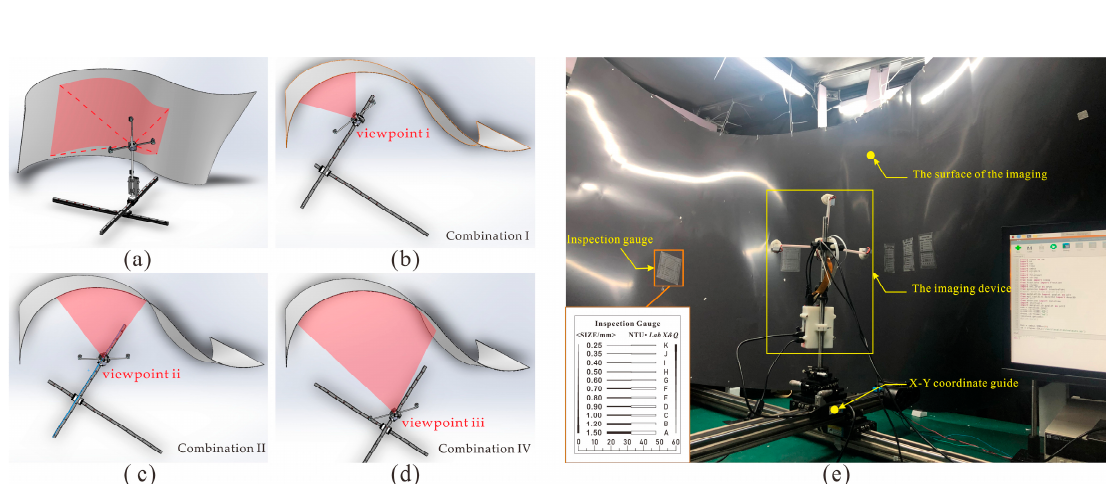
Figure 6. Experimental scene: ( a ) experimental scene model; ( b ) viewpoint i; ( c ) viewpoint ii; ( d ) viewpoint iii. When the model is at the location of viewpoints i, ii, and iii, the type of imaging combination becomes combinations I, II, and IV, respectively. ( e ) The actual scenario, where the clarity of the image can be judged by observing the thin line on the “inspection gauge”. Table 1. Consistency parameter configuration.